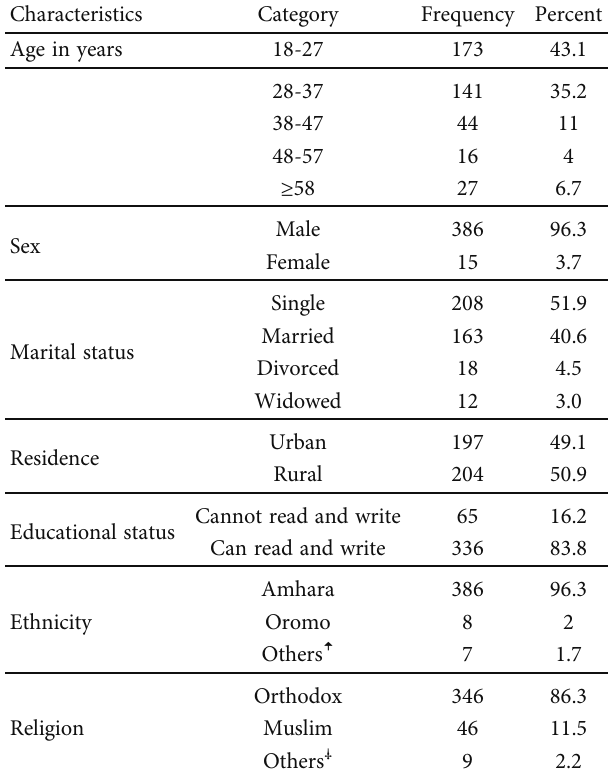
Table 2: Sociodemographic characteristics of respondents in North Wollo zone correctional institutions, Northeast Ethiopia.